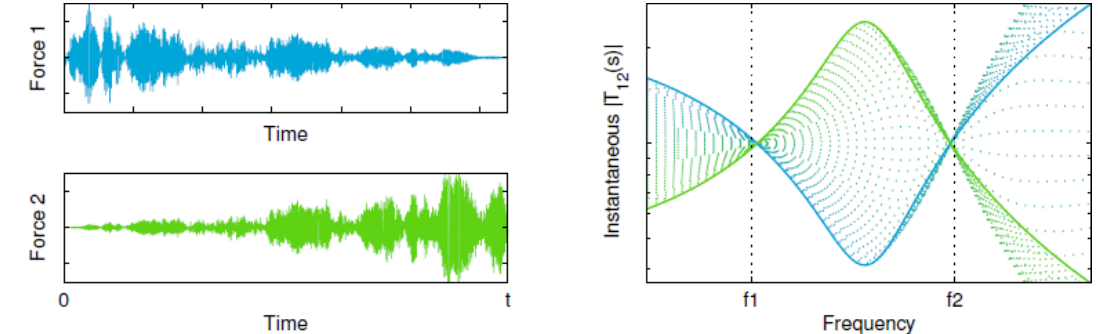
Figure 16. Instantaneous transmissibility functions T 12 (right) shown for the case where the input location of the load varies over time from position 1 to 2 (left). Instantaneous values of T 12 show the same property as time-invariant transmissibilities in that they converge at the system poles (Weijtjens et al.,